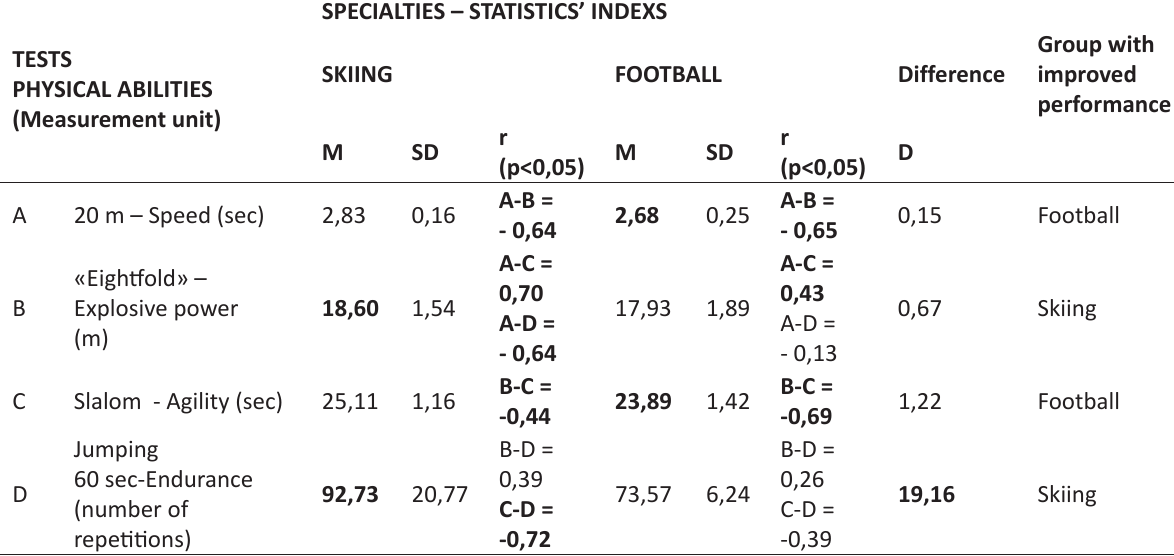
Table 2. Comparison of physical abilities between skiing and football specialization teams